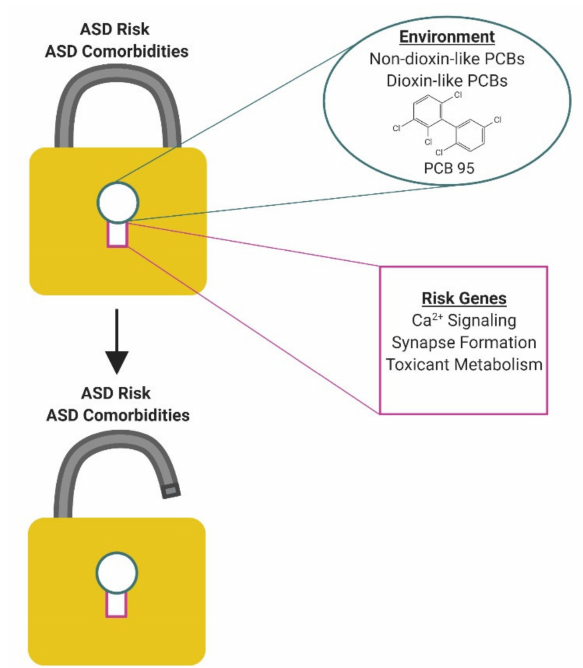
Figure 2. Lock and key model of ASD. The risk for autism spectrum disorder (ASD) and its comorbidities can be thought of as a lock that opens when the keys of environmental exposure to PCBs, risk genes, and timing fit into the lock key-hole. Each individual’s lock may be slightly di ff erent, contributing to the clinical heterogeneity of ASD. Created with